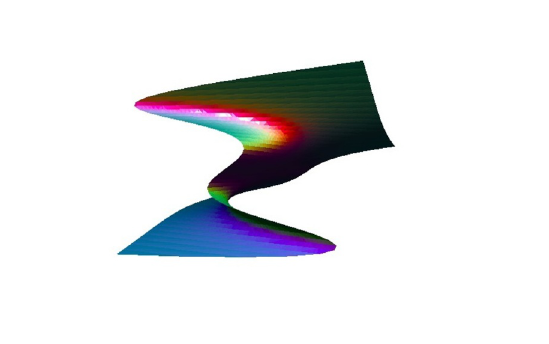
Figure 10 . Smooth degree five spectral